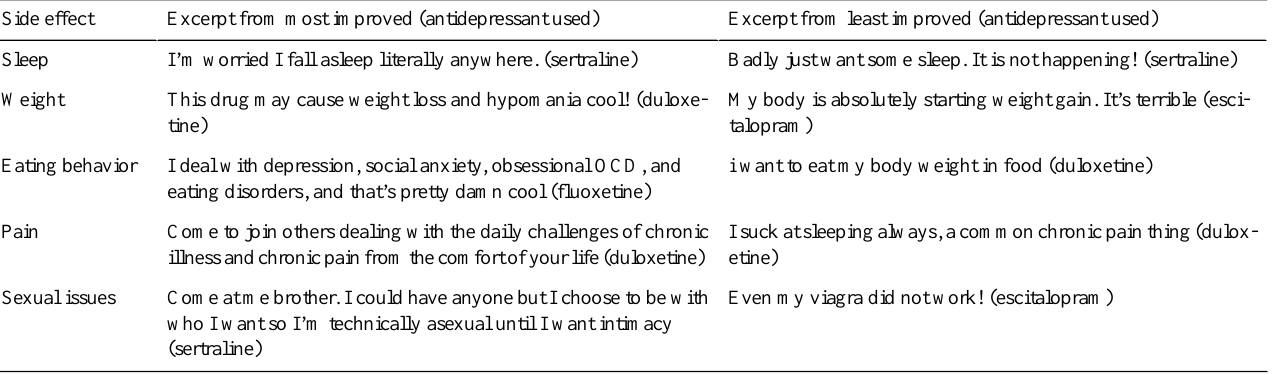
Table 2. Excerpts from individuals who improved the most and